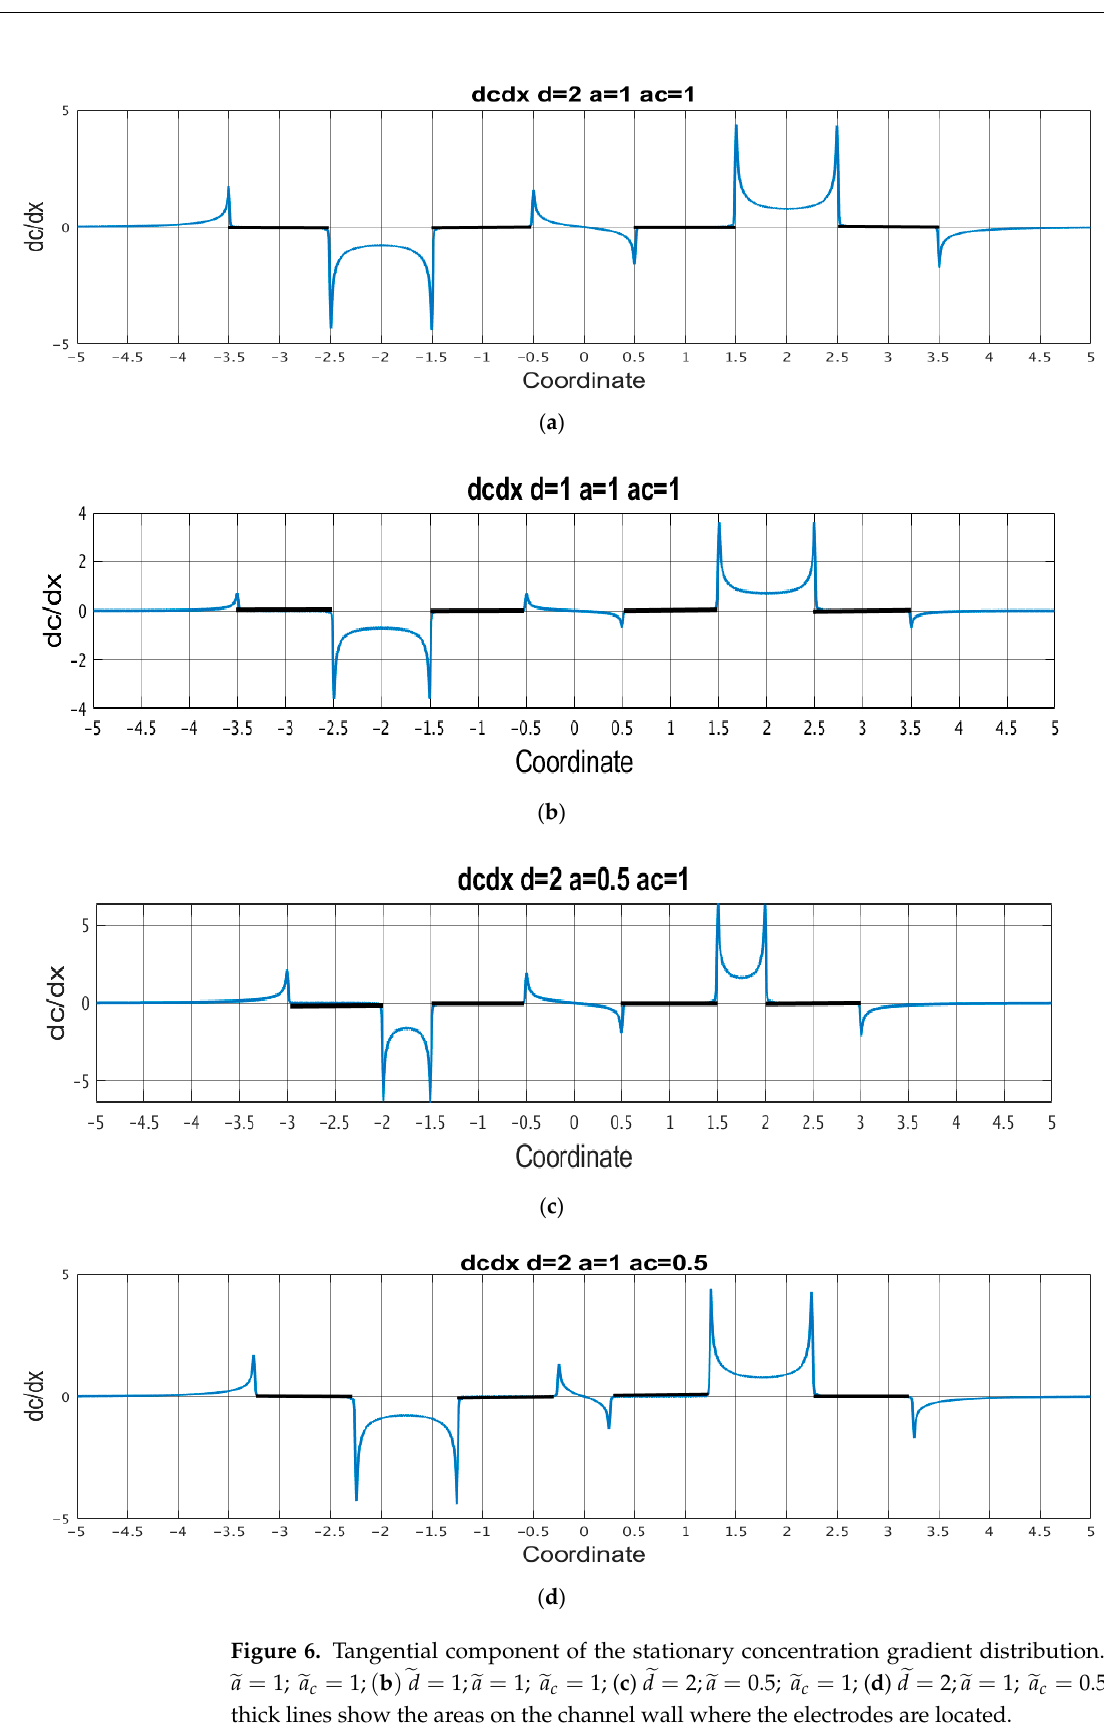
Figure 6. Tangential component of the stationary concentration gradient distribution. ( a ) (cid:101) d = 2; (cid:101) a = 1; (cid:101) a c = 1; ( b ) (cid:101) d = 1; (cid:101) a = 1; (cid:101) a c = 1; ( c ) (cid:101) d = 2; (cid:101) a = 0.5; (cid:101) a c = 1; ( d ) (cid:101) d = 2; (cid:101) a = 1; (cid:101) a c = 0.5. The black thick lines show the areas on the channel wall where the electrodes are located.